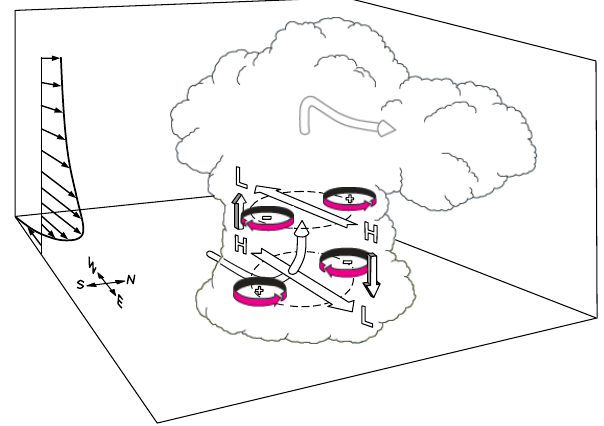
Figure 6. A schematic showing the distribution of dynamical pres- sure perturbations (marked by “H” for anomalous high and “L” for anomalous low) relative to a mature storm cell in an environment with the presence of a westerly low-level jet (LLJ) and westerly (easterly) vertical shear below (above) the jet core as in our case. The configuration is in favor of new development at the rear side and a slower moving speed of the